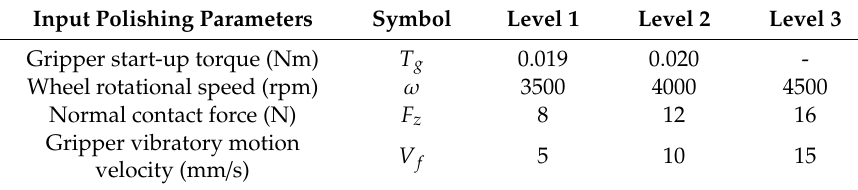
Table 1. Input polishing parameters and levels.